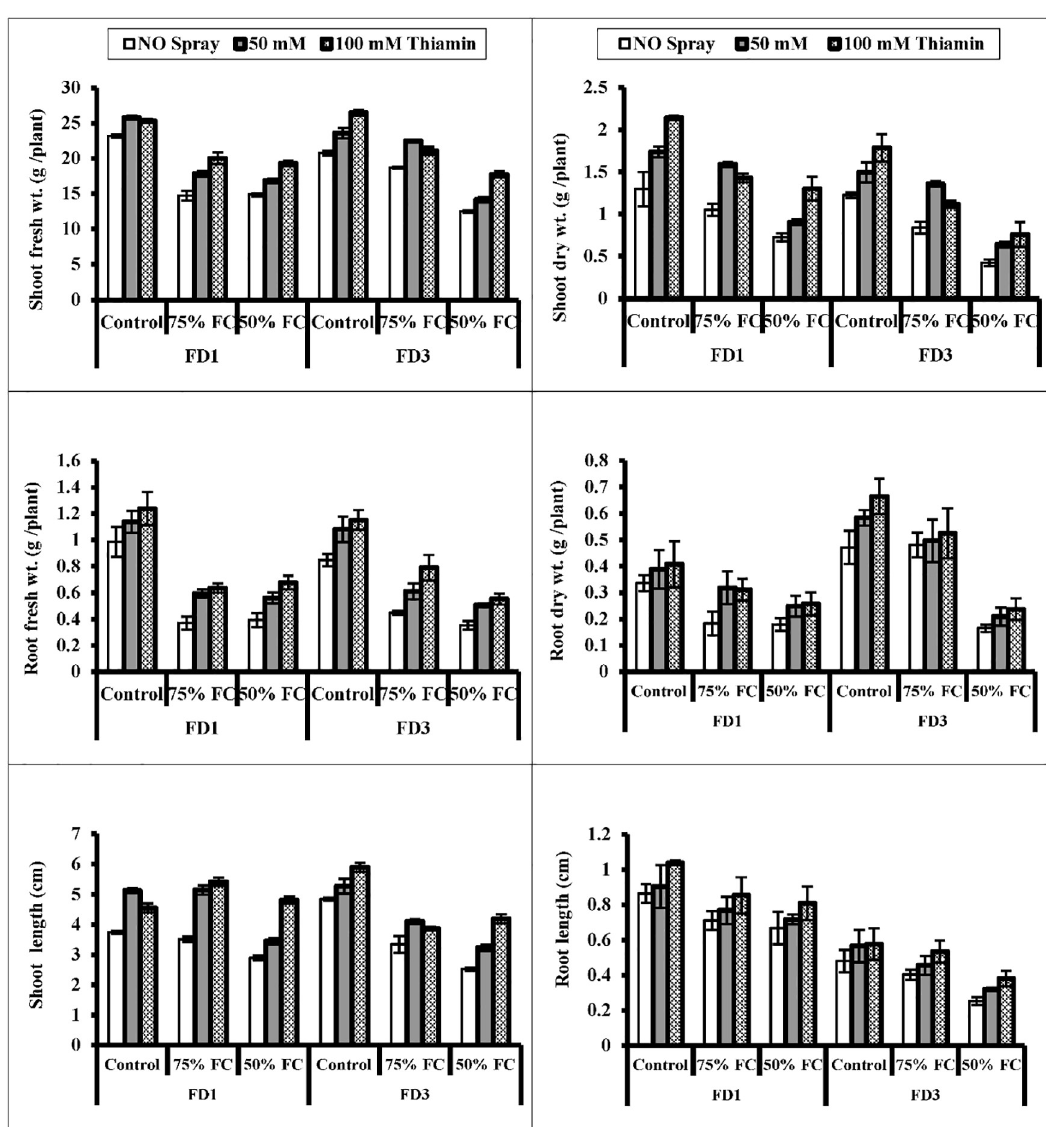
Fig 1. Shoot and root fresh and dry weights, shoot and root lengths of two cultivars of cauliflower ( Brassica oleracea L.) plants foliarly treated with thiamin (50 and 100 mM) subjected to control (100% field capacity) and drought stress (75% and